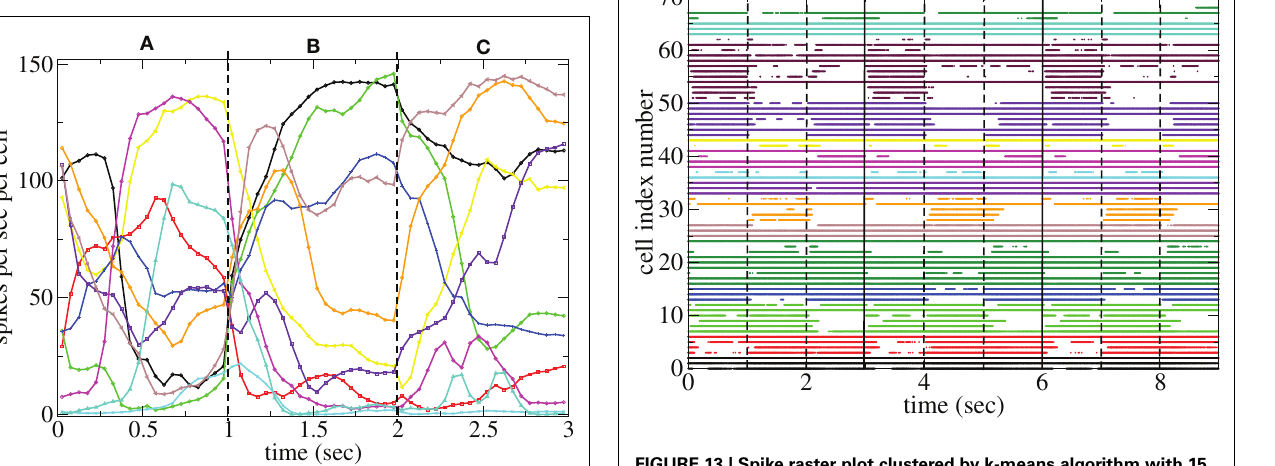
FIGURE 12 | PSTH of clusters corresponding to Figure 11 and colored the same way in spikes per second per cell.